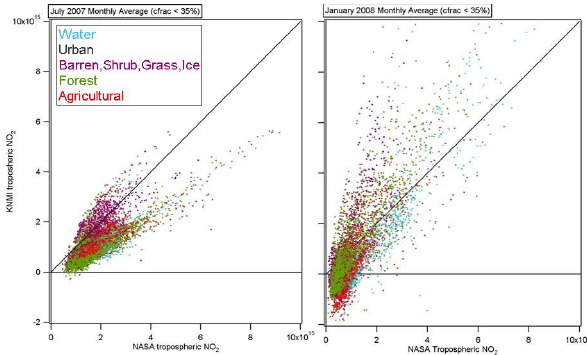
Fig. 12. KNMI vs. NASA tropospheric NO 2 from OMI for summer (July 2007 at left) and winter (January 2008 at right) monthly av- erages in molecules per square centimeter. Color denotes dominant land class type within the cell. Ideally a user may expect the distri- bution to fall roughly along the 1 to 1 line, if the two OMI products agreed